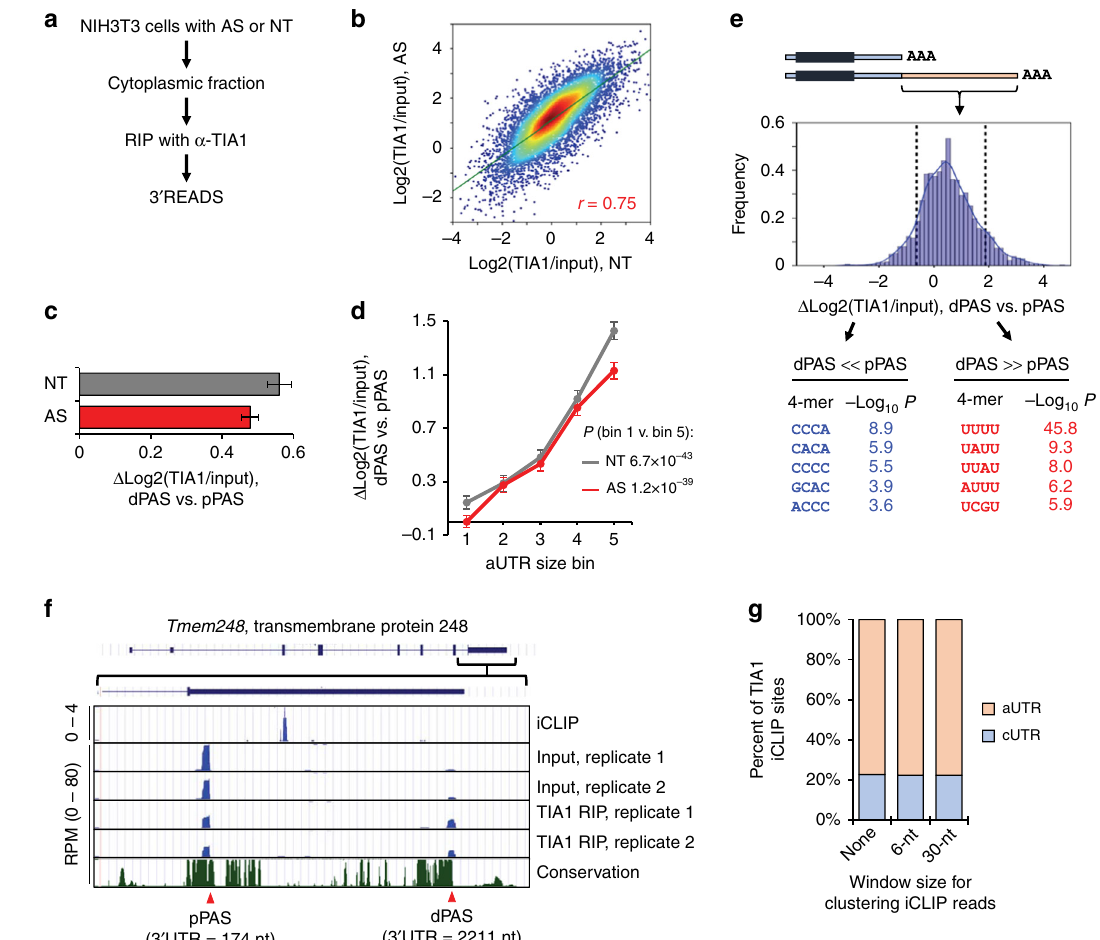
Fig. 3 TIA1 preferentially binds to long aUTRs via U-rich motifs. a Schematic of 3 ′ READS + RIP. The cytoplasmic fraction of NT or AS cells was used for ribonucleoprotein immunoprecipitation (RIP) with a TIA1 antibody. Two replicates were used for both input and RIP samples. b Correlation of log2(TIA1/ input) values in NT and AS cells. Pearson correlation coef fi cient r is indicated. c Differences in TIA1 binding between distal pA isoforms (dPAS) and proximal pA isoforms (pPAS), as measured by median Δ log2(TIA1/Input), dPAS vs. pPAS, under NT (gray) or AS (red) condition. Error bars are standard deviation of median RED based on random sampling of the data for 20 times (see Methods for details). d Relationship between Δ log2(TIA1/Input) and aUTR size. Genes were divided into fi ve bins based on aUTR size as in Fig. 1f. Error bars are standard error of mean based on all genes in each bin. P -values (Wilcoxon test) for comparing genes in bin 1 vs. in bin 5 are shown. e Top, distribution of Δ log2(TIA1/Input) values representing TIA1 binding difference between long and short 3 ′ UTR isoforms under AS. Top and bottom 10% genes were selected for sequence motif analysis. Bottom, tetramers enriched in the aUTRs of top 10% of genes (dPAS » pPAS), or of bottom 10% of genes (dPAS « pPAS). Top fi ve enriched tetramers are shown for each group of genes. Their P -values (Fisher ’ s exact test) are indicated. Only the data from AS cells were used. f TIA1 iCLIP and RIP-3 ′ READS data of an example gene Tmem248